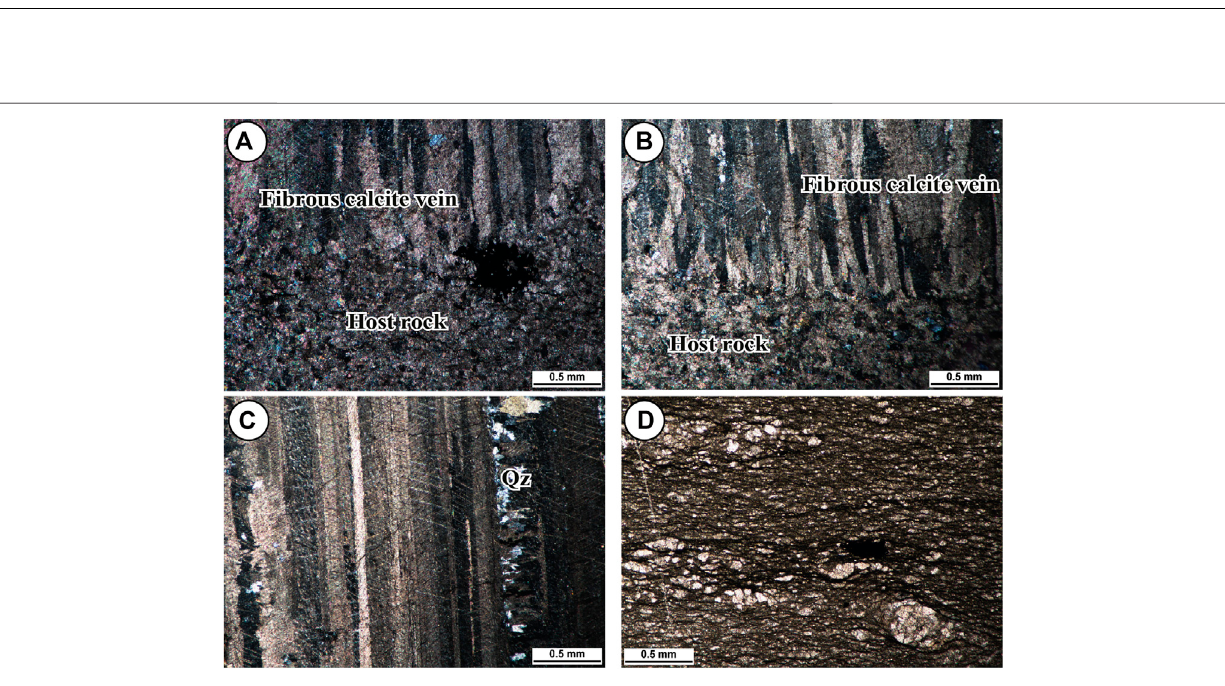
Frontiers in Earth Science |